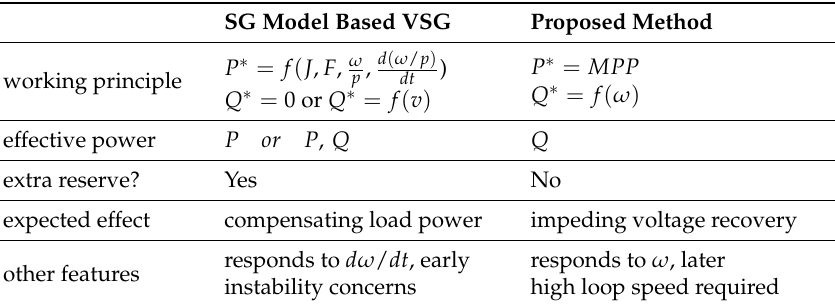
Table 1. Features of VSG and the proposed Q/f